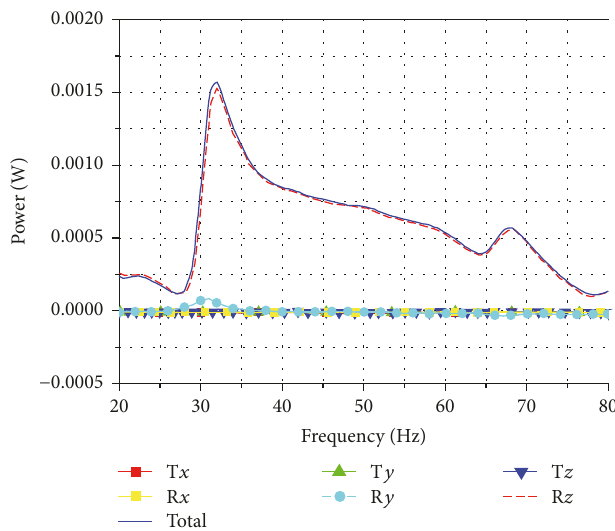
Figure 14: Power of transmission shaft support bushing in 6